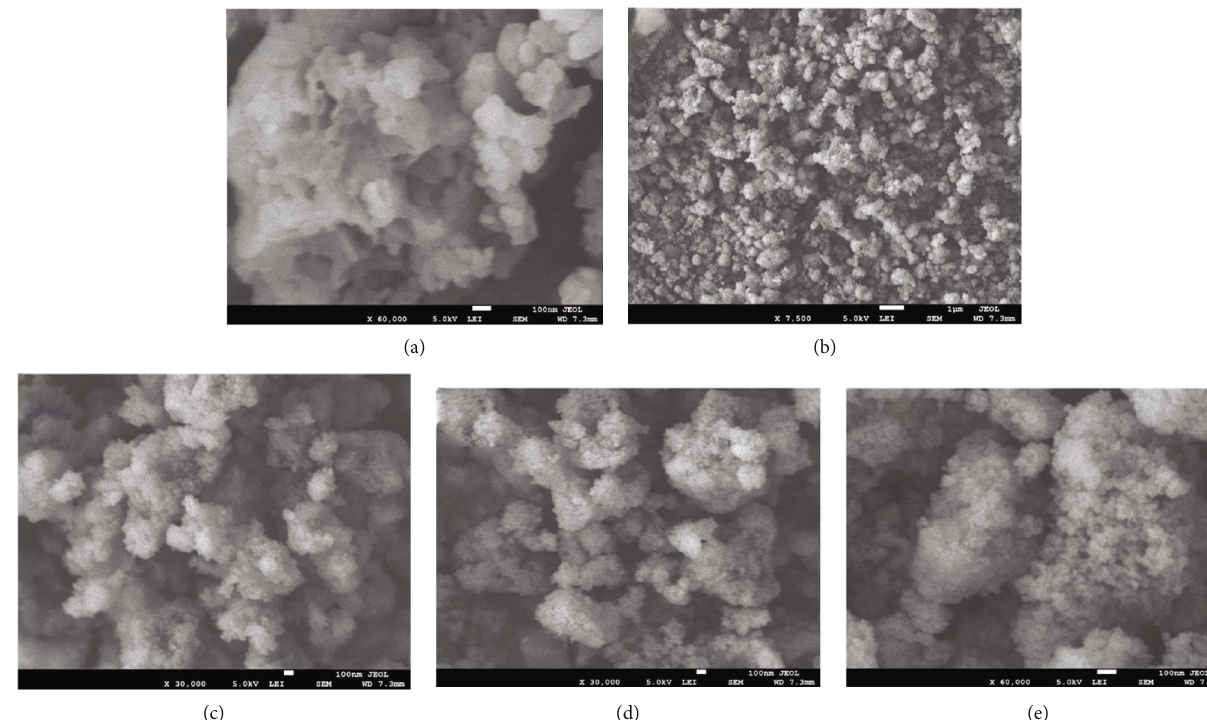
Figure 3: SEM images of the P3NT (a), AgTiO P3NT/30%AgTiO